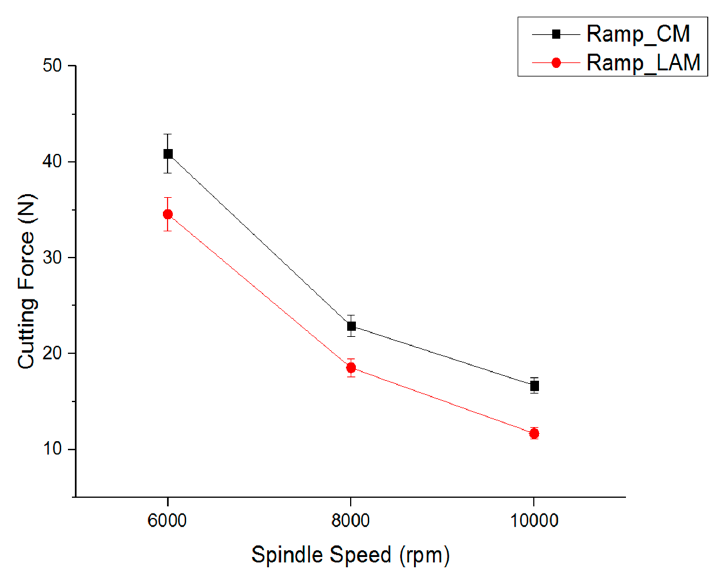
Figure 16. Experiment results by the feed rate 200 mm/min in ramp milling.